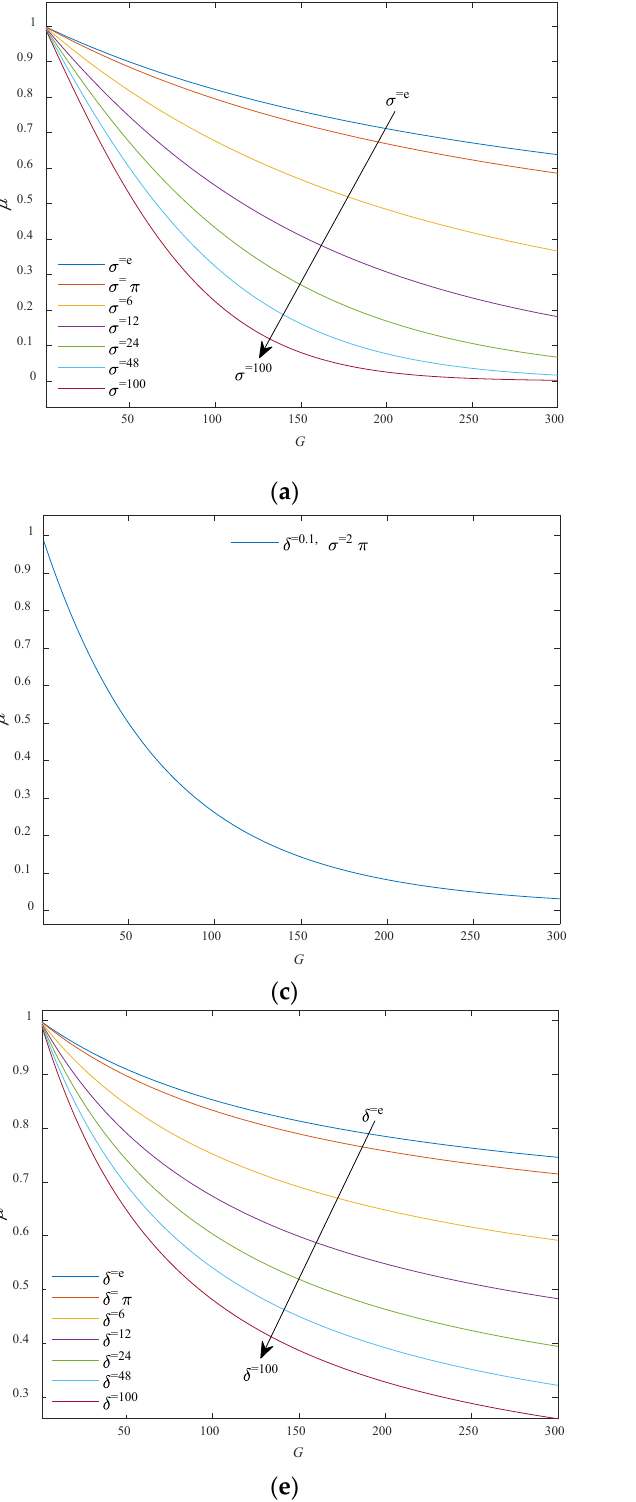
( f ) = 0.5 and σ was increasing be- = 0.1 𝛿𝛿 𝛿𝛿